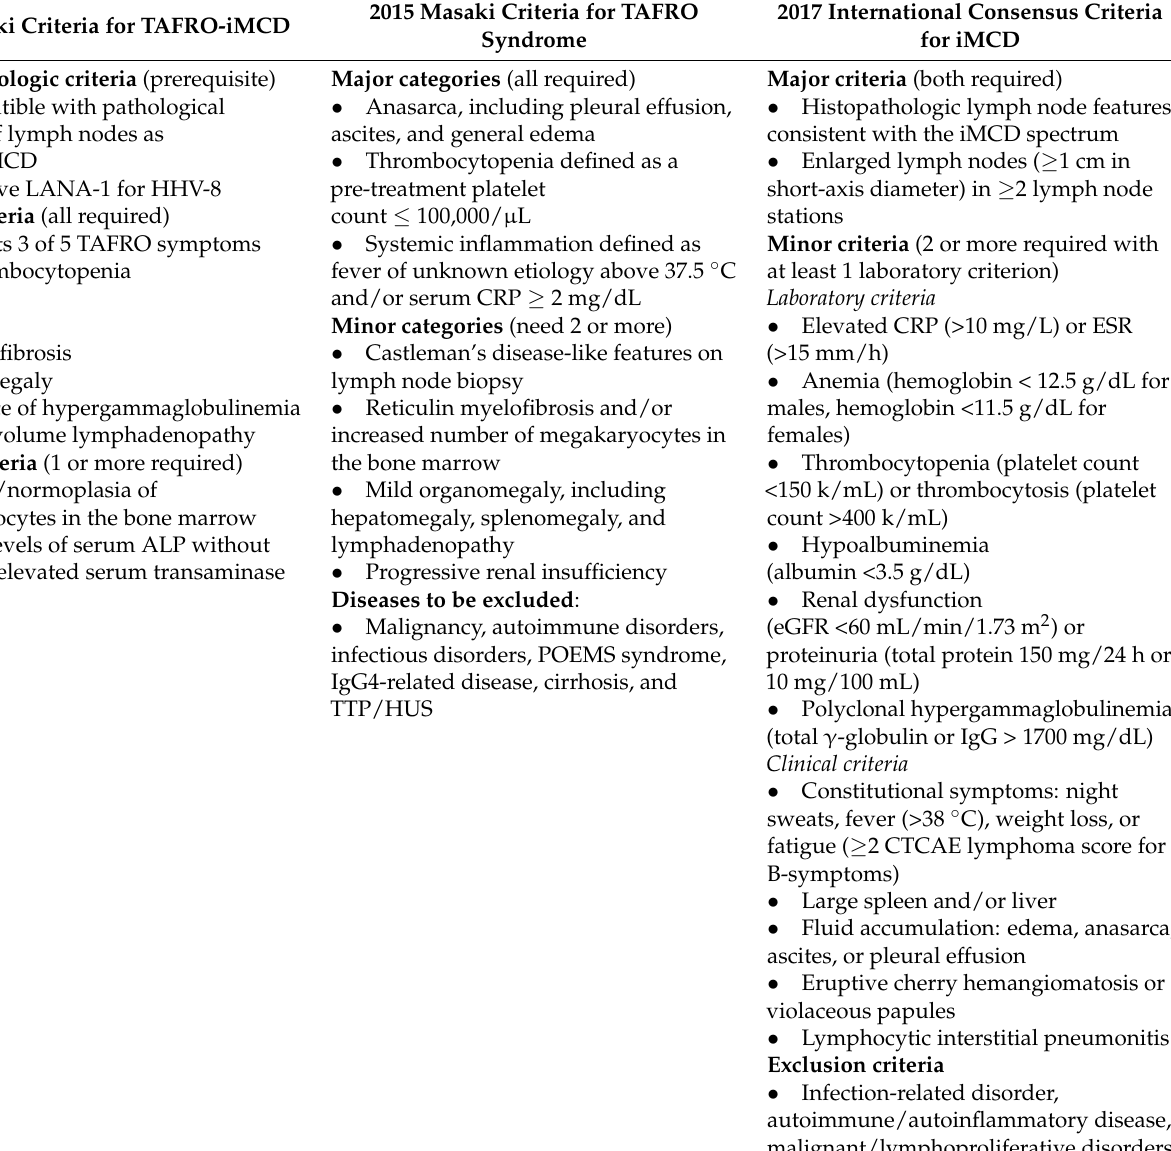
Table 1. Comparison of diagnostic criteria of the idiopathic multicentric Castleman disease and TAFRO